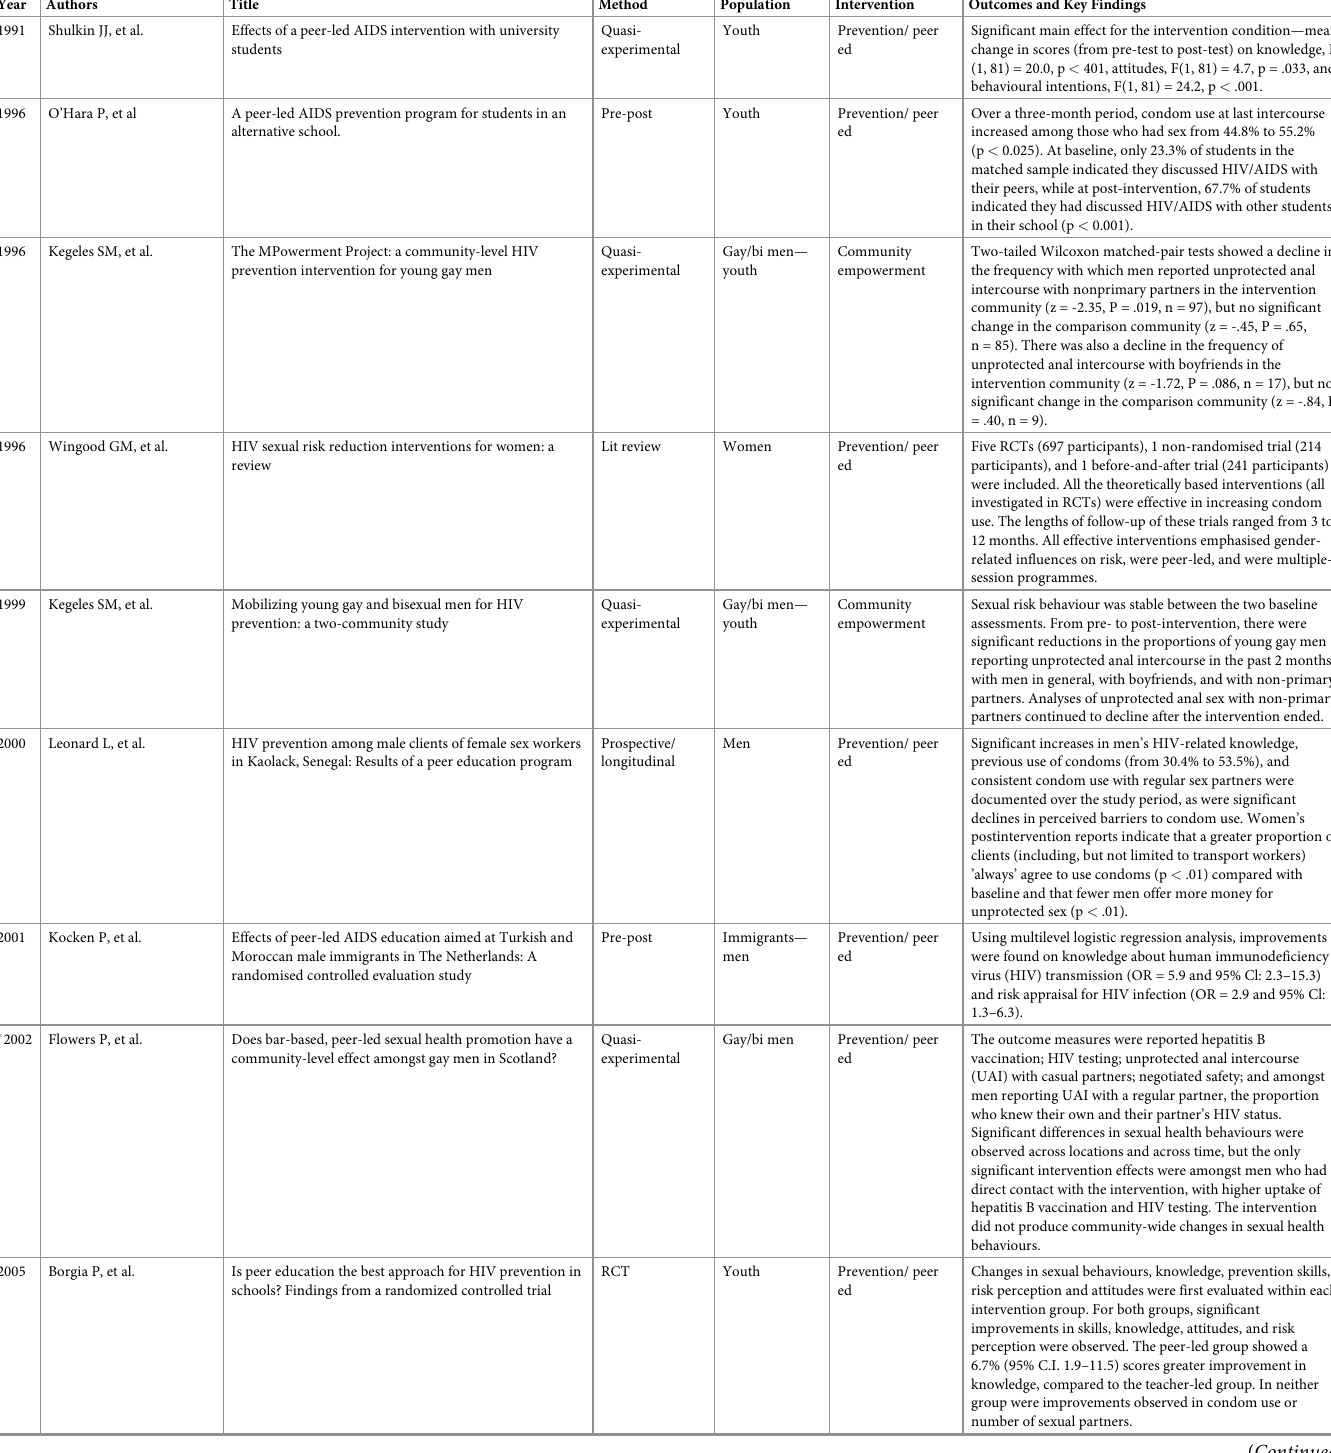
Table 2. Studies examining community- or peer-led service delivery and reported